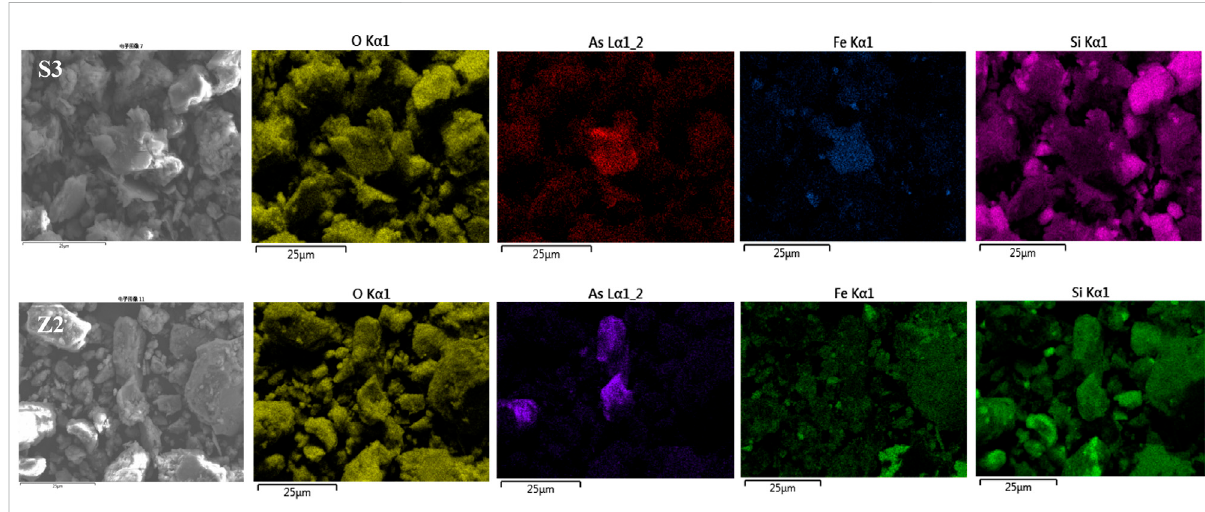
FIGURE 6 SEM-EDX elemental maps of the soil and slags (S3, Z2). The degree of brightness represents the relative element content, and the higher the relative element content when the brighter the area